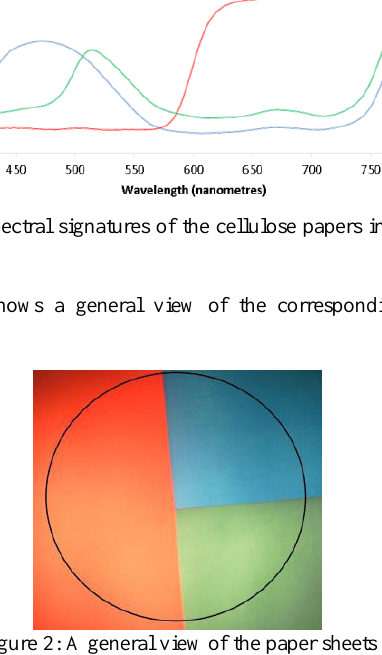
Figure 3: A schematic view of the experimental set up for spectral measurements in the